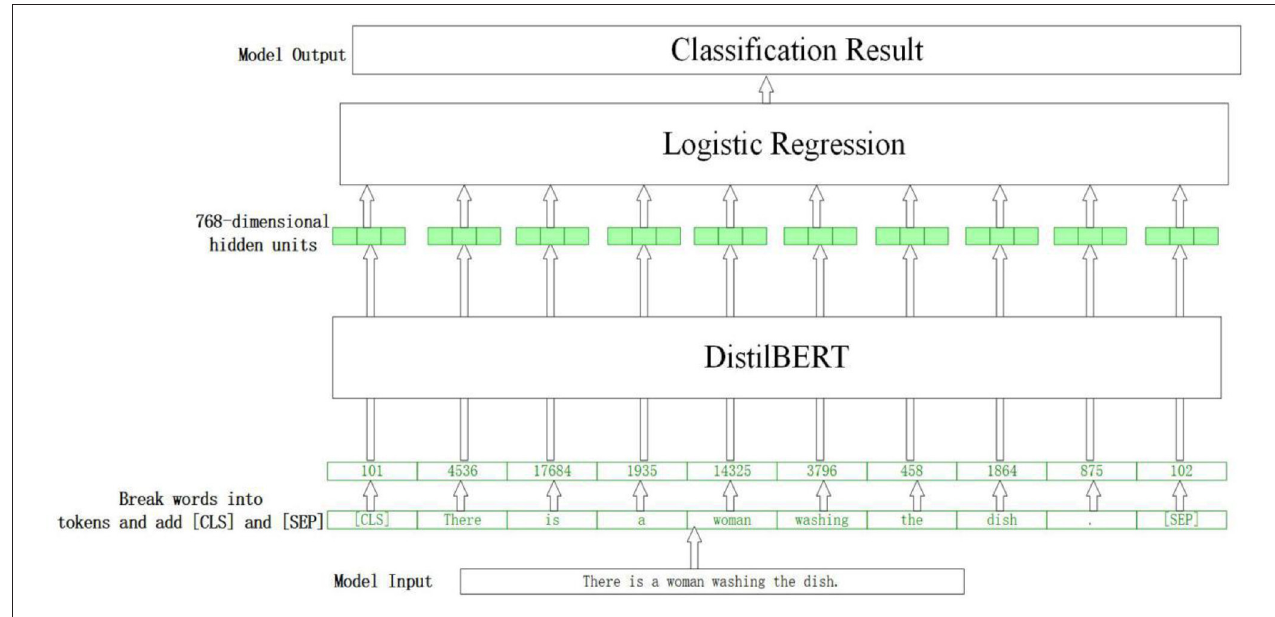
FIGURE 1 | The logical architecture of the model.